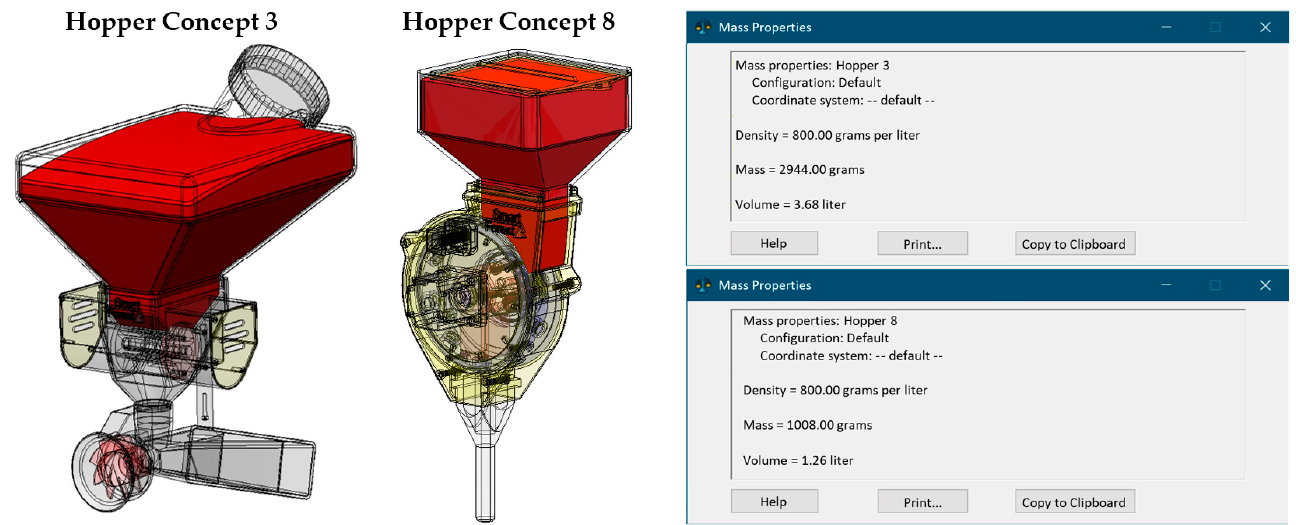
Figure 8. Determination of the payload of the sowing devices.